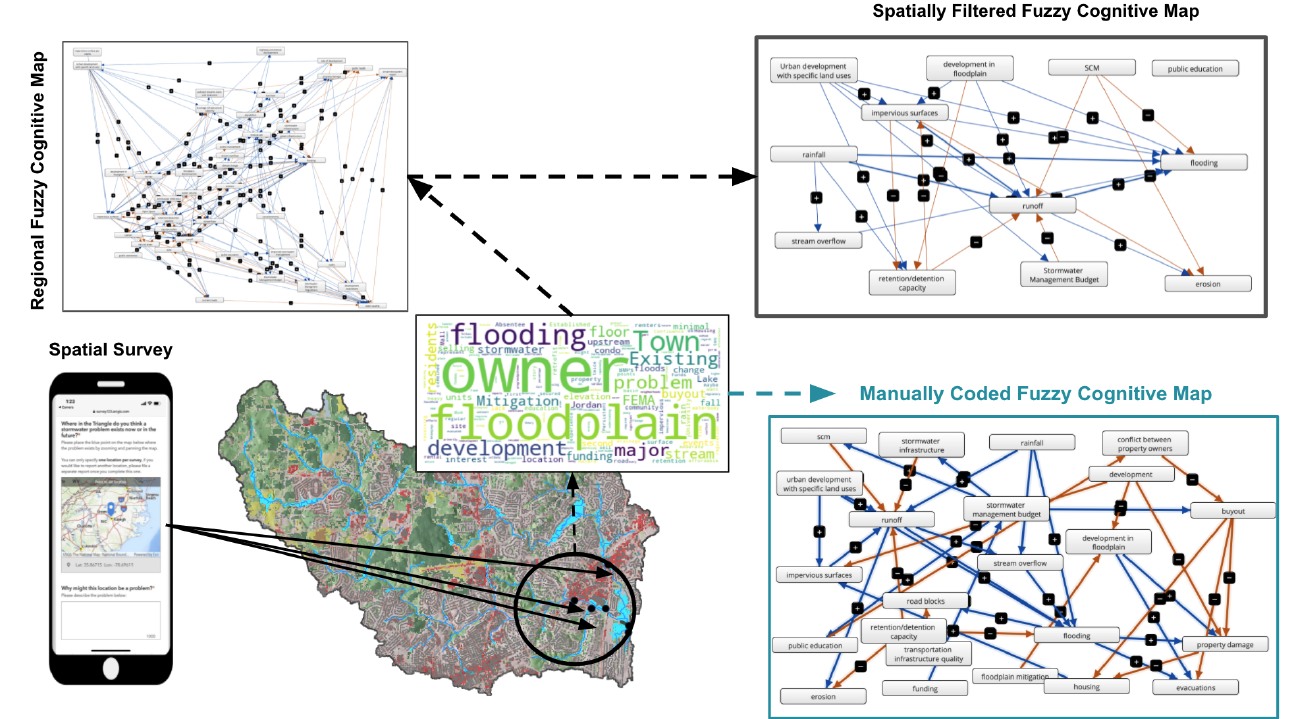
Figure 4. By coupling spatially explicit survey data with a regional fuzzy cognitive map of stormwater management, we generated spatially filtered FCMs to explore the role of spatial scale in FCMs. The process starts by creating a regional FCM and collecting spatially explicit survey data about the same system. The text responses from the survey are then parsed and matched to variables used in the regional FCM. The result from this process is a spatially filtered version of the regional FCM. A manually coded FCM is also independently generated from the survey responses to capture variables and relationships not identified in the regional